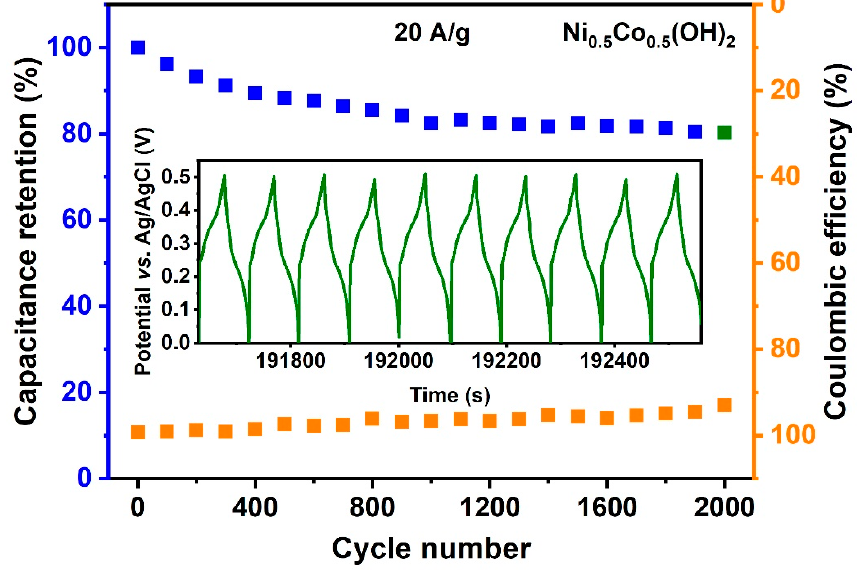
Figure 8. Cycling performance and coulombic efficiency of the Ni 0.5 Co 0.5 (OH) 2 electrode.